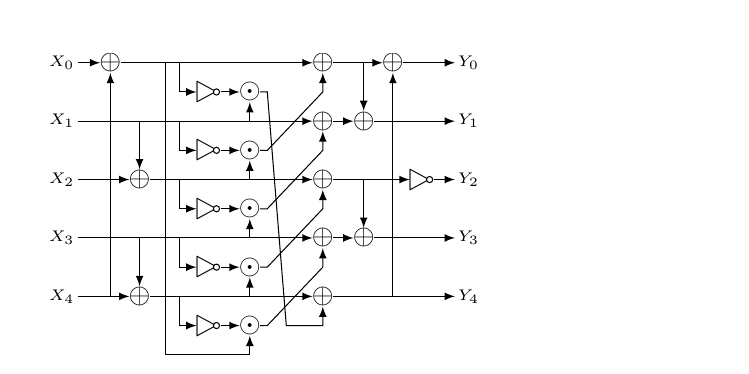
Figure 4: Bitsliced implementation of the substitution layer